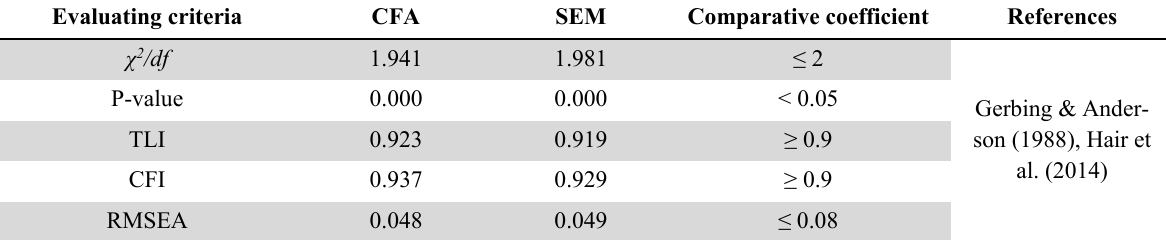
CFA and SEM analytical result Evaluating